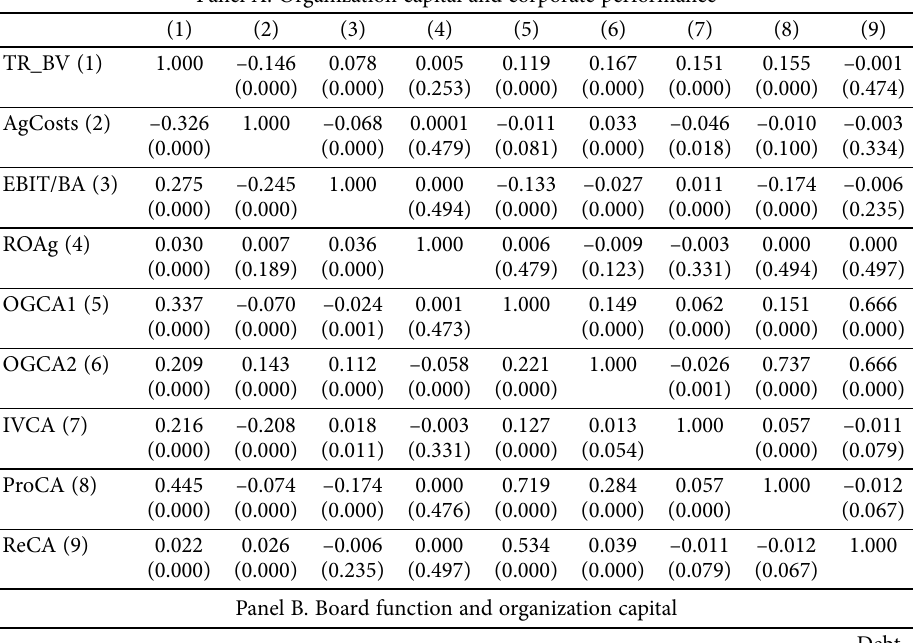
Table 3. Correlation coefficient matrix